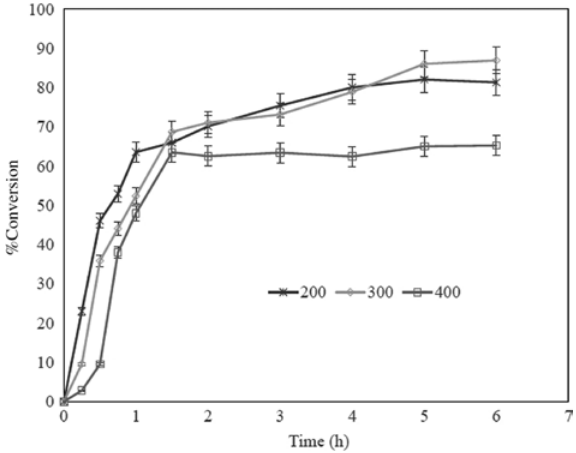
Figure 5: Effect of molecular sieves on reaction conversion at stearic acid to PEG 600 ratio 1:4, temperature 70 ° C, catalyst loading Fermase 0.5% (w/w), and speed of agitation 300